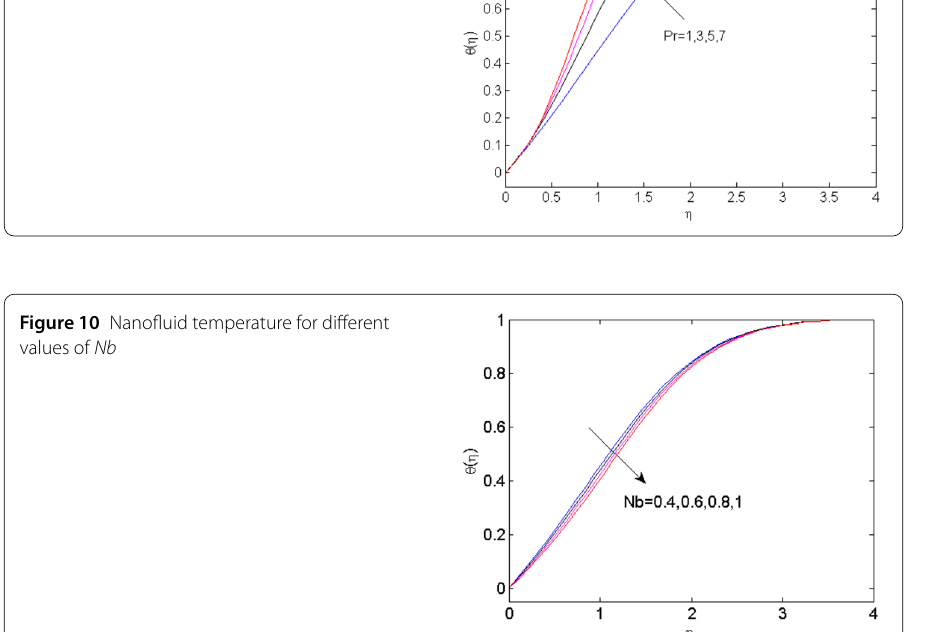
Figure 9 Nanofluid temperature for different values of P r